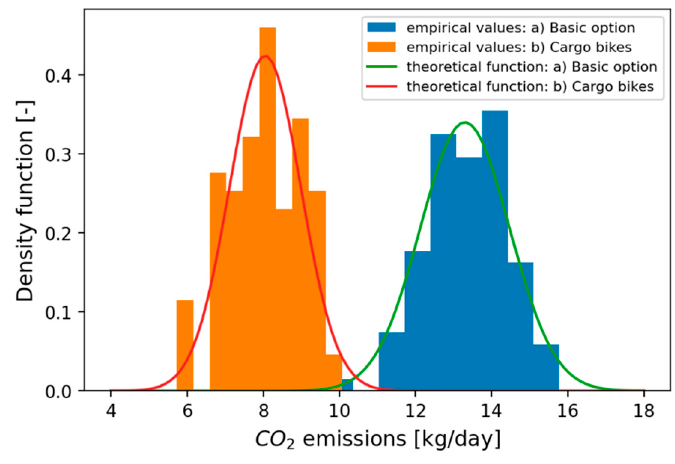
Figure 7. Distribution of the CO 2 emissions based on the results of simulations for San Sebastian.